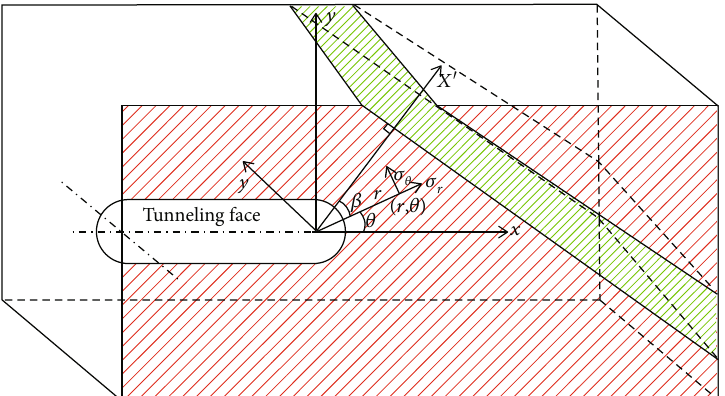
Figure 3: Hypothesis of the “ strong and soft face ” in crosscut